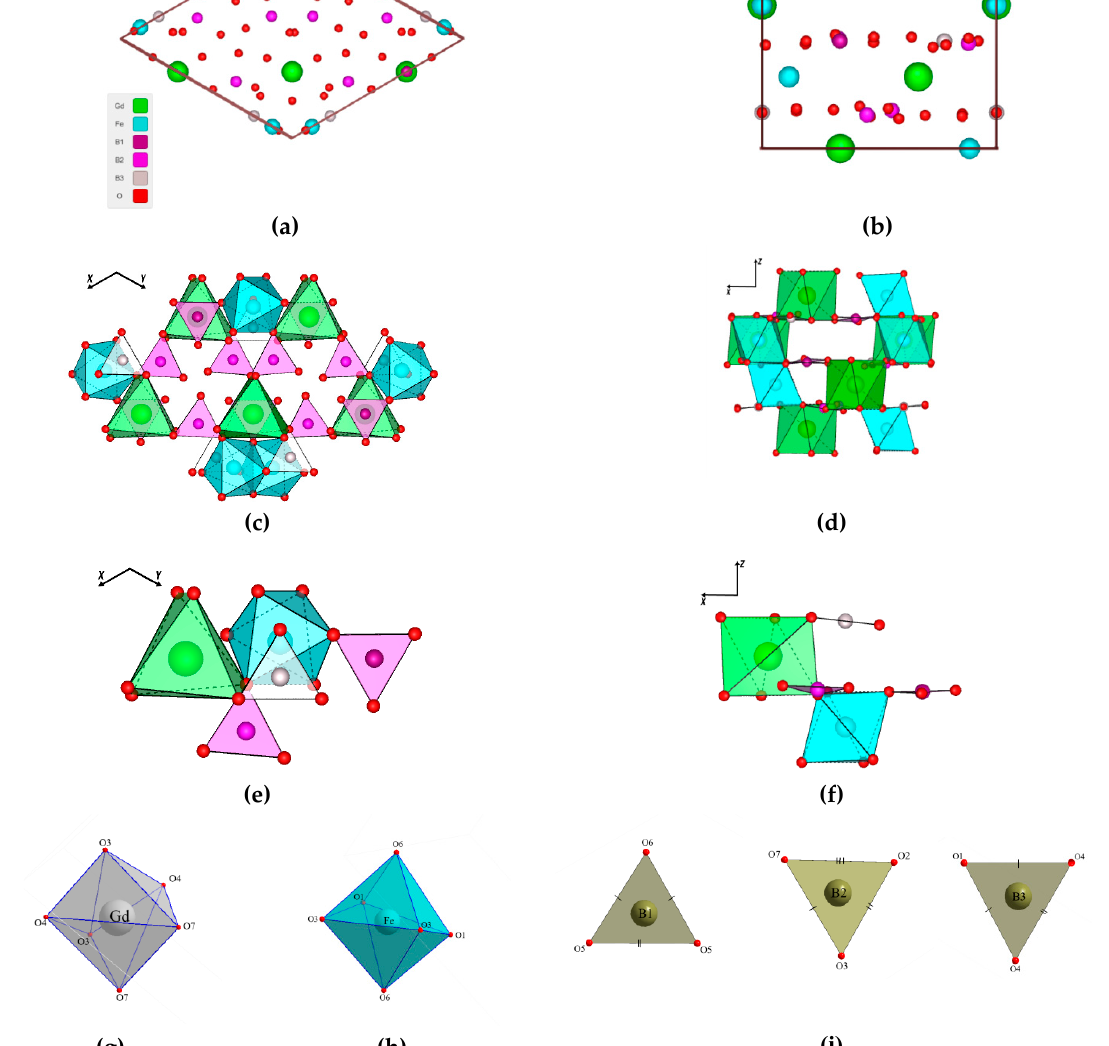
Figure 13. The unit cell of the GdFe 3 (BO 3 ) 4 structure (space group P 3 1 21) projected onto the ( a ) XY and ( b ) XZ planes; Combination of the coordination polyhedra projected onto the ( c ) XY and ( d ) XZ planes; Combination of selected coordination polyhedra projected onto the ( e ) XY and ( f ) XZ planes; Coordination polyhedra for the ( g ) Gd, ( h ) Fe, ( i ) B1–B3.